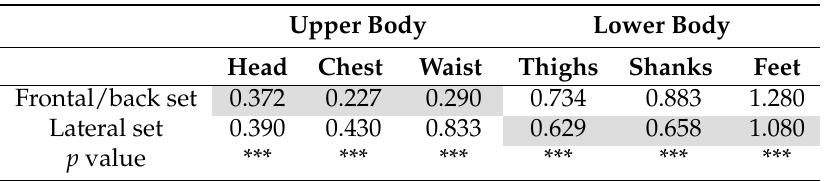
Table 8. Paired t -test on error angles in “incremental” comparison between the IMUs placed on different sides of body segments.